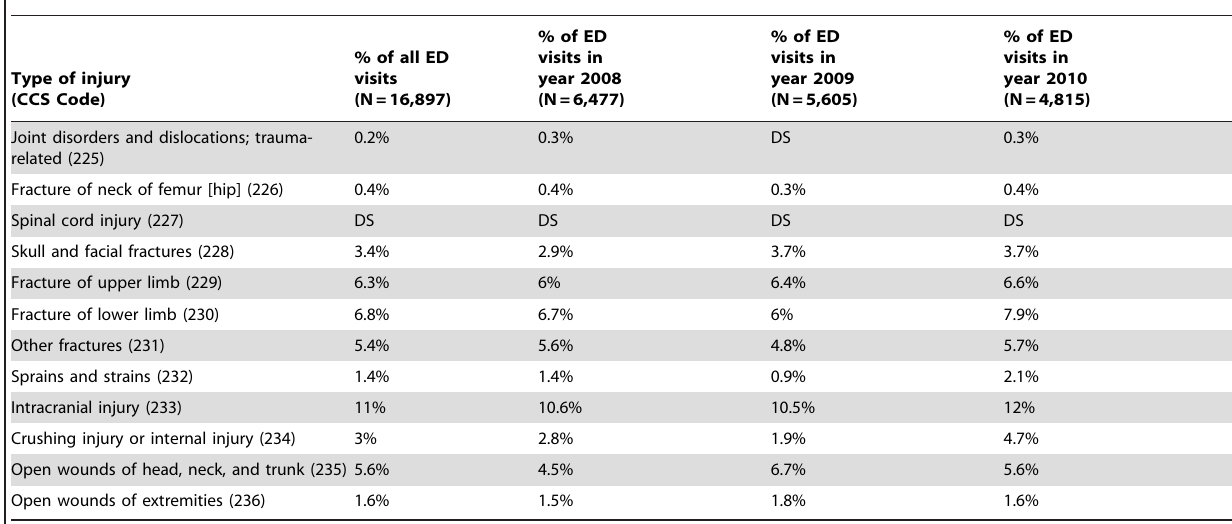
Table 2. Types of Injuries in patients visiting the Emergency Department.